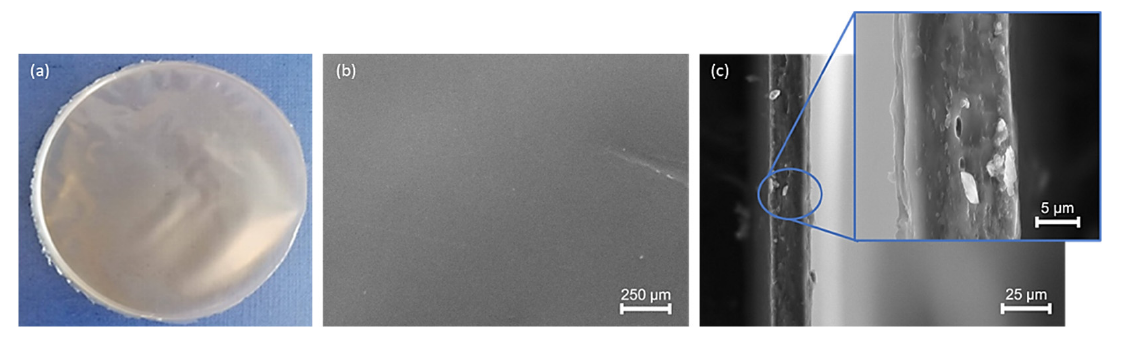
Figure 8. Film prepared with d − FucoPol ( a ) and its observation by SEM: surface ( b ) and cross-section ( c ) images.